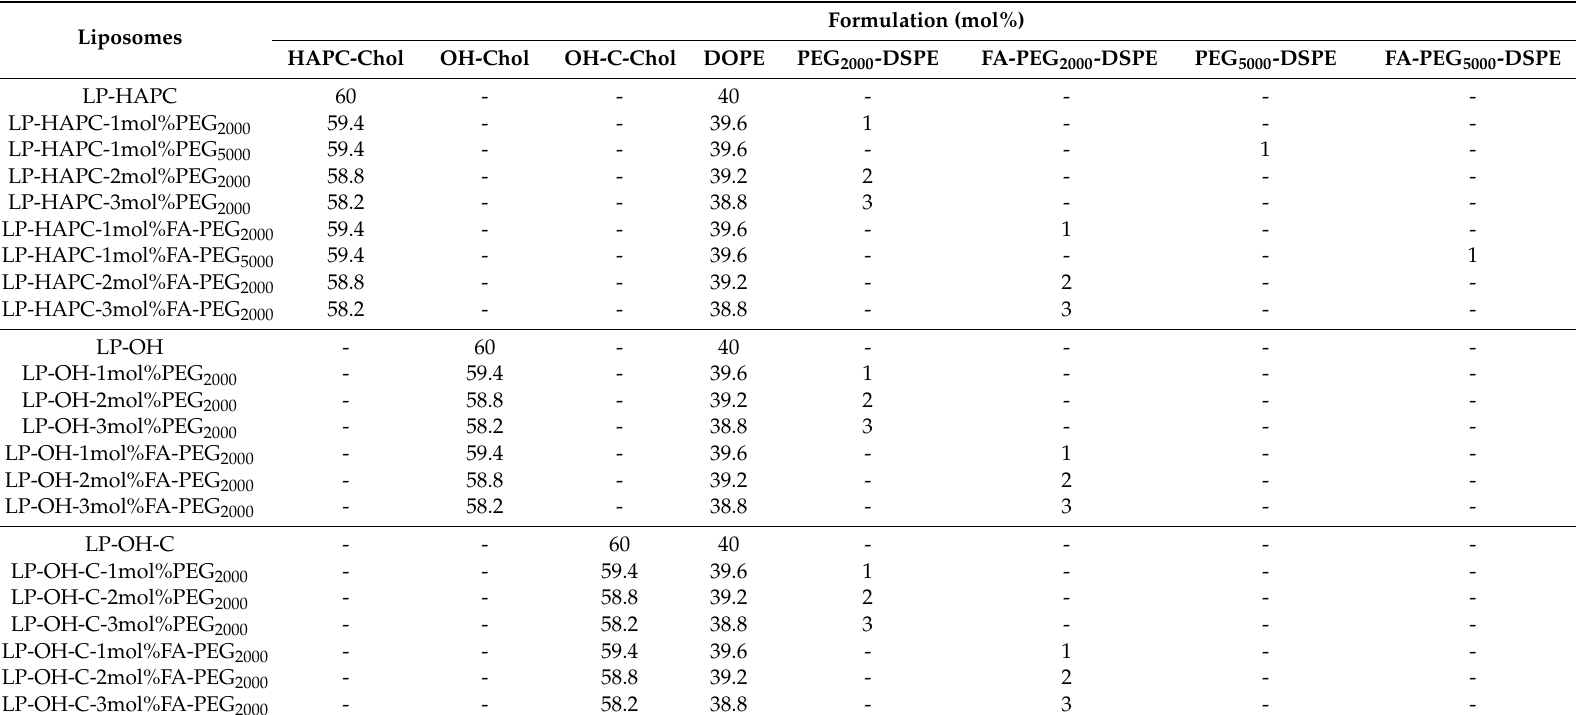
Table 1. Formulation of FA-modified cationic